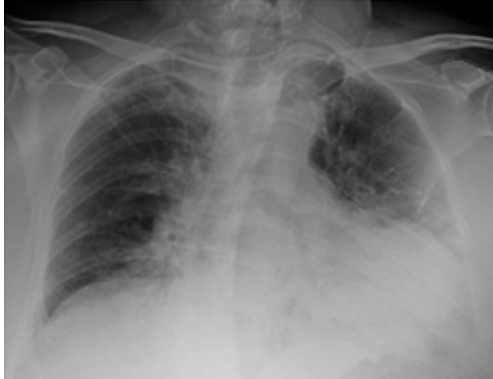
Figure 6. Dense infiltrate in the left lower lobe.